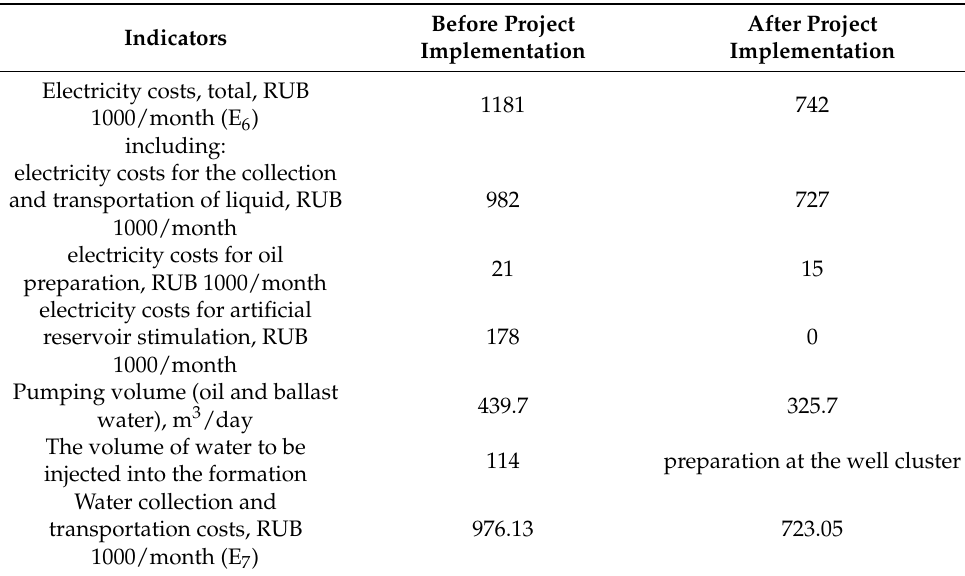
Table 10. Initial data for the environmental and economic assessment of the project for the implemen- tation of cluster separation technology for well